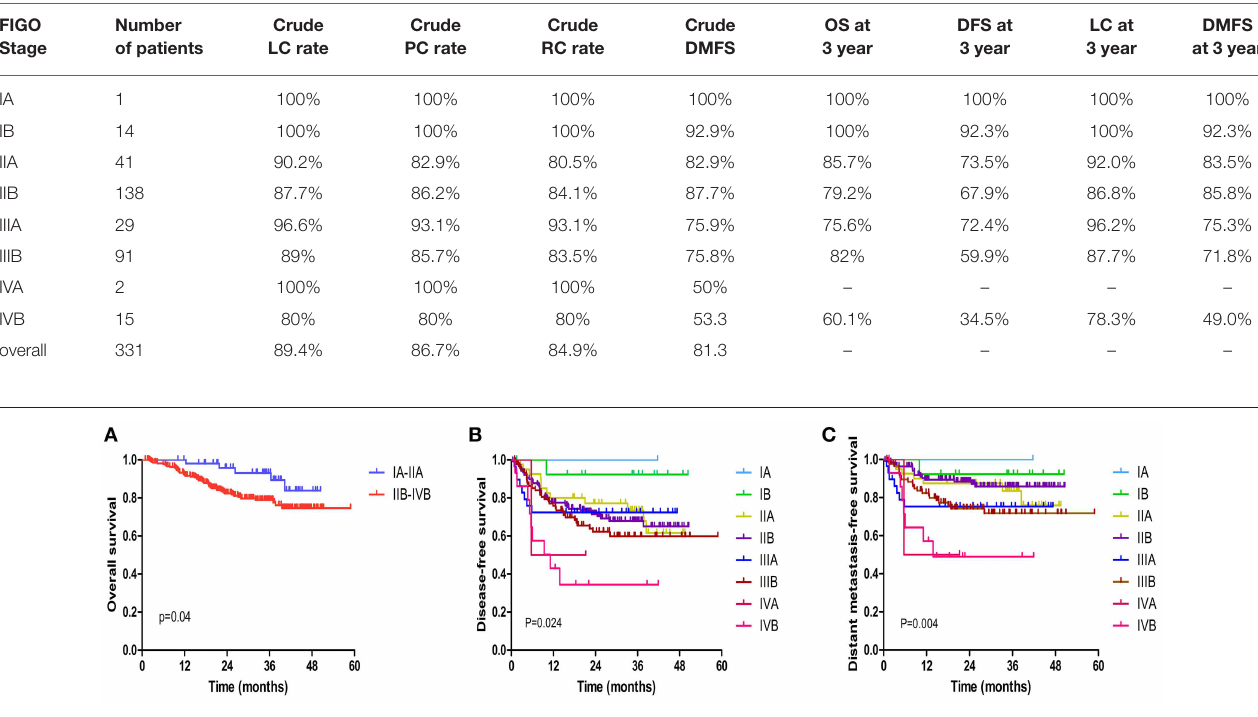
FIGURE 2 | Kaplan-Meier estimated of the overall survival (OS) (A) , disease-free survival (DFS) (B) , and distant metastasis free survival (DMFS) (C) according to the FIGO stage treated with VMAT.